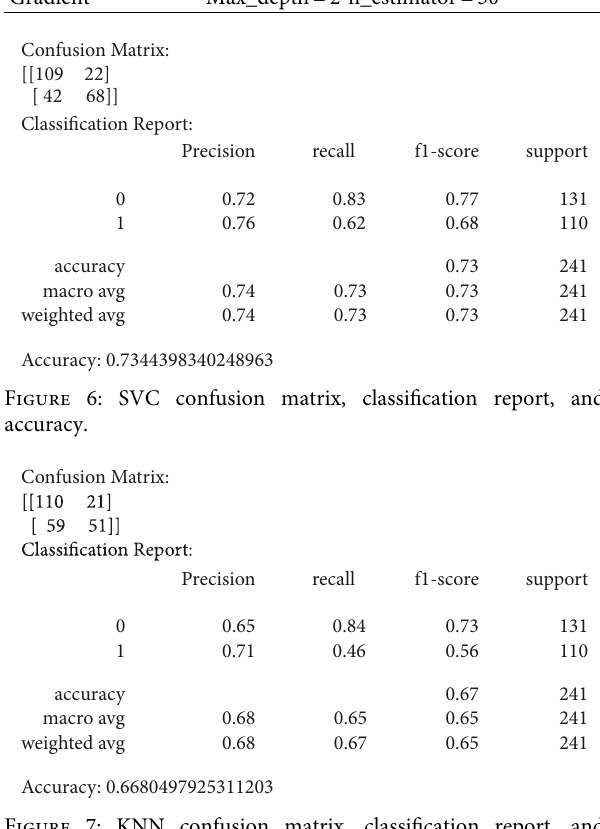
Figure 7: KNN confusion matrix, classification report, and accuracy.